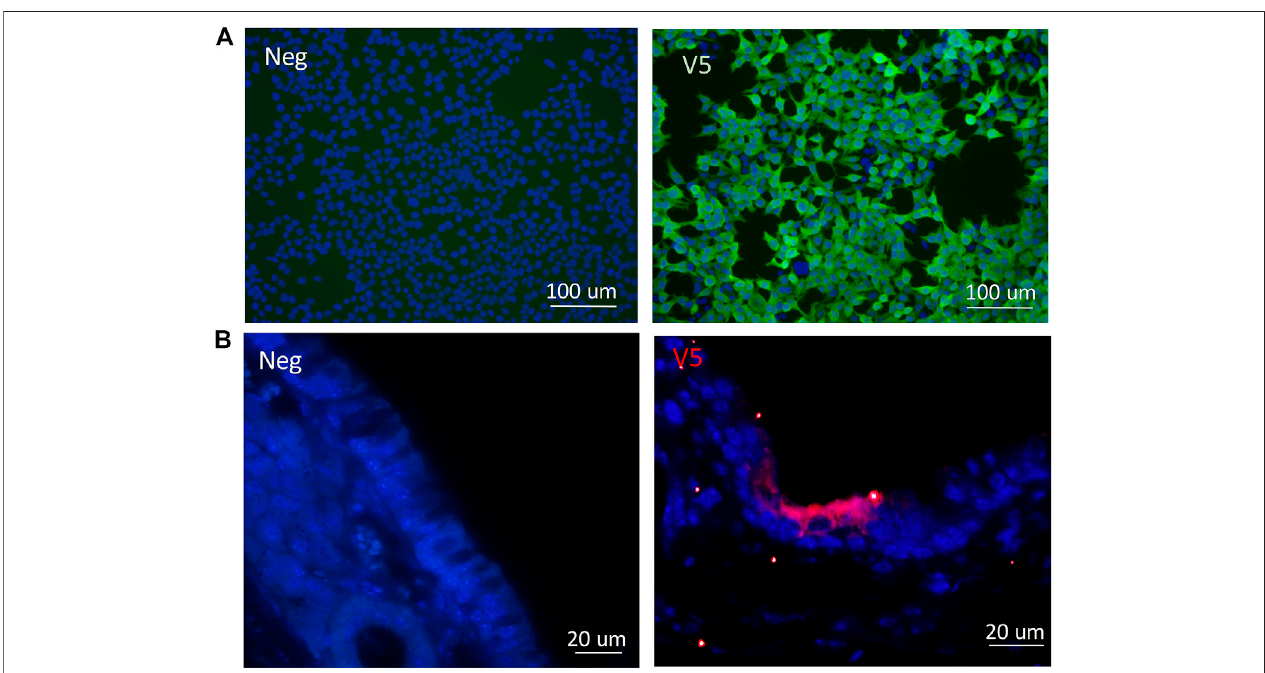
FIGURE 6 | Validation of the V5 tag following delivery of the CCL-V5- CFTR vector in (A) in vitro samples of HEK293T cells by ICC; (B) in mouse ciliated nasal epithelium using IHC. All merged images (DAPI blue, V5 green or red) with non-CFTR treated cells or CF animals as negative controls (neg) on left panels, V5 staining images on right